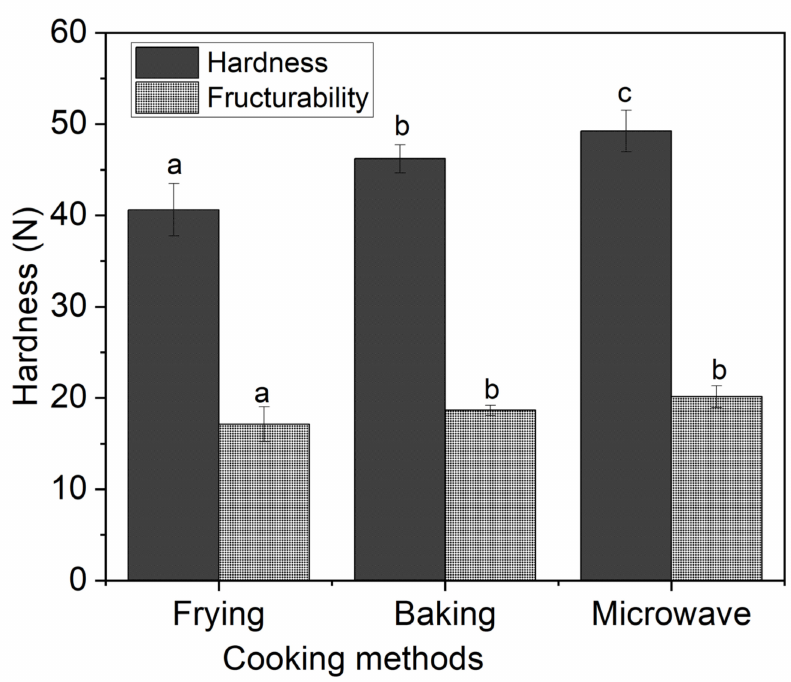
Figure 2. Effect of processing methods on textural characteristics of fish meat-based snacks. The results of texture parameters are the mean and standard deviation of six snacks for each treatment. Different letters (a,b,c) over the error bars indicate the significant difference between processing methods at p < 0.05 using one-way ANOVA and Duncan’s multiple range